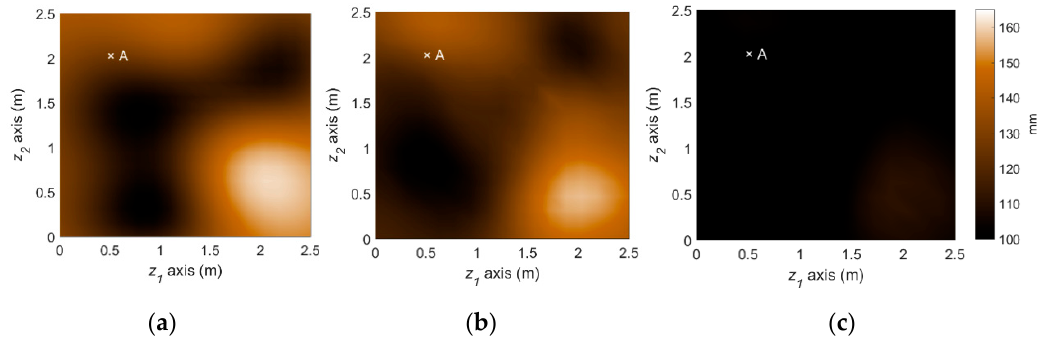
Figure 9. Prediction of deterioration pattern: ( a ) Reference; ( b ) Particle filter with parameter updating (proposed); ( c ) Particle filter without parameter updating